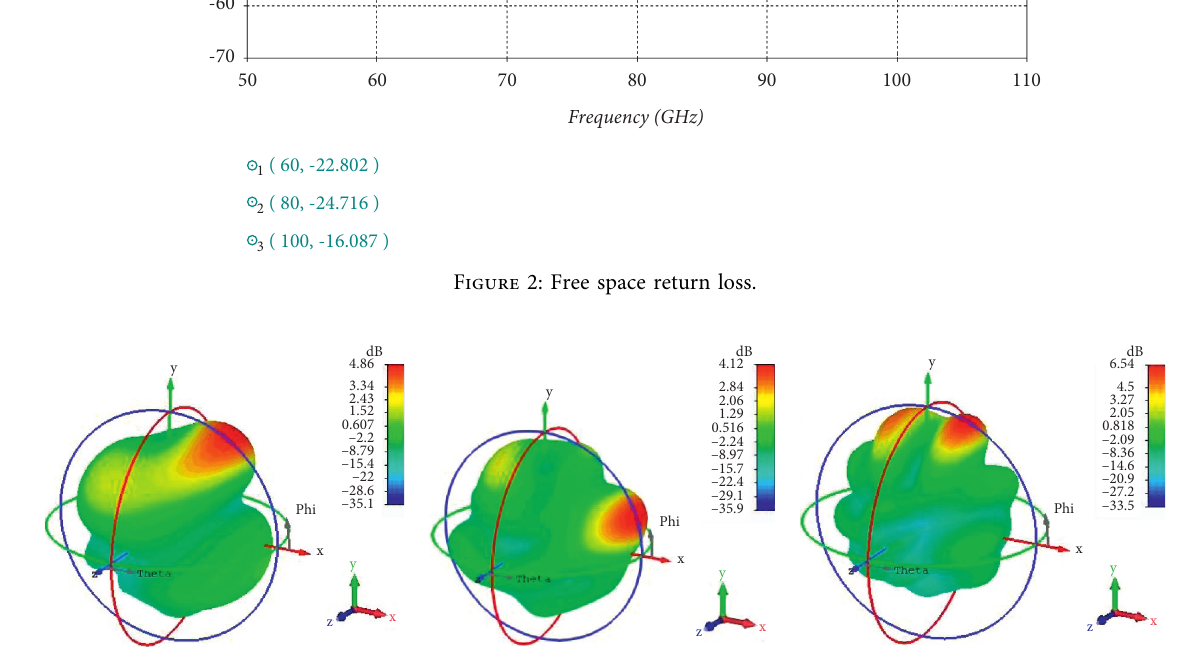
Figure 3: 3D radiation patterns at (a) 60 GHz, (b) 80GHz, and (c) 100GHz (from left to right).